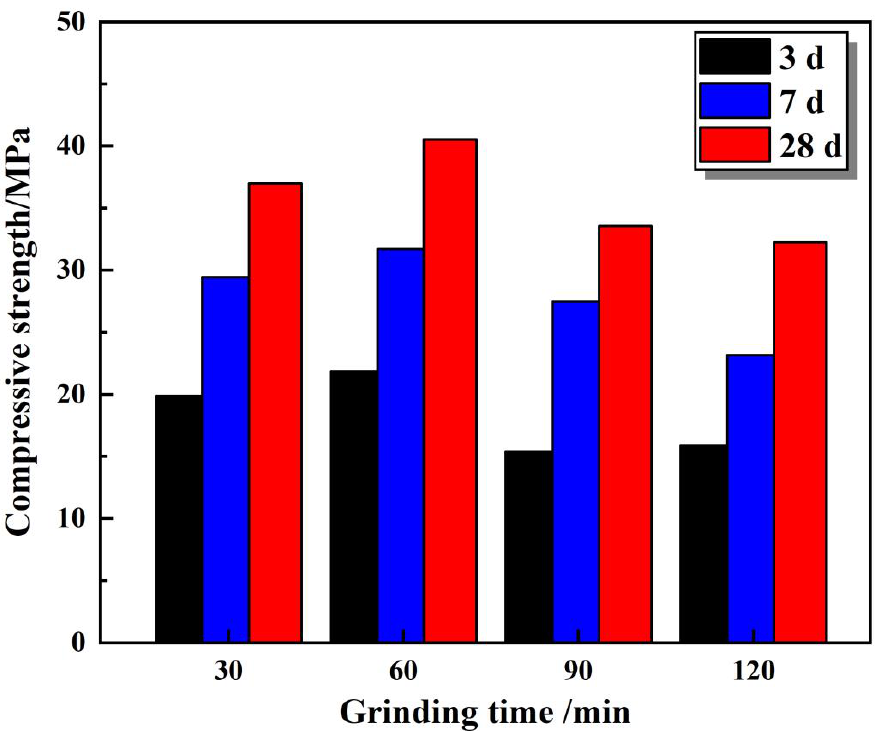
Figure 4. Relationship between grinding time of lead – zinc tailings and compressive strength of cement mortar [95].